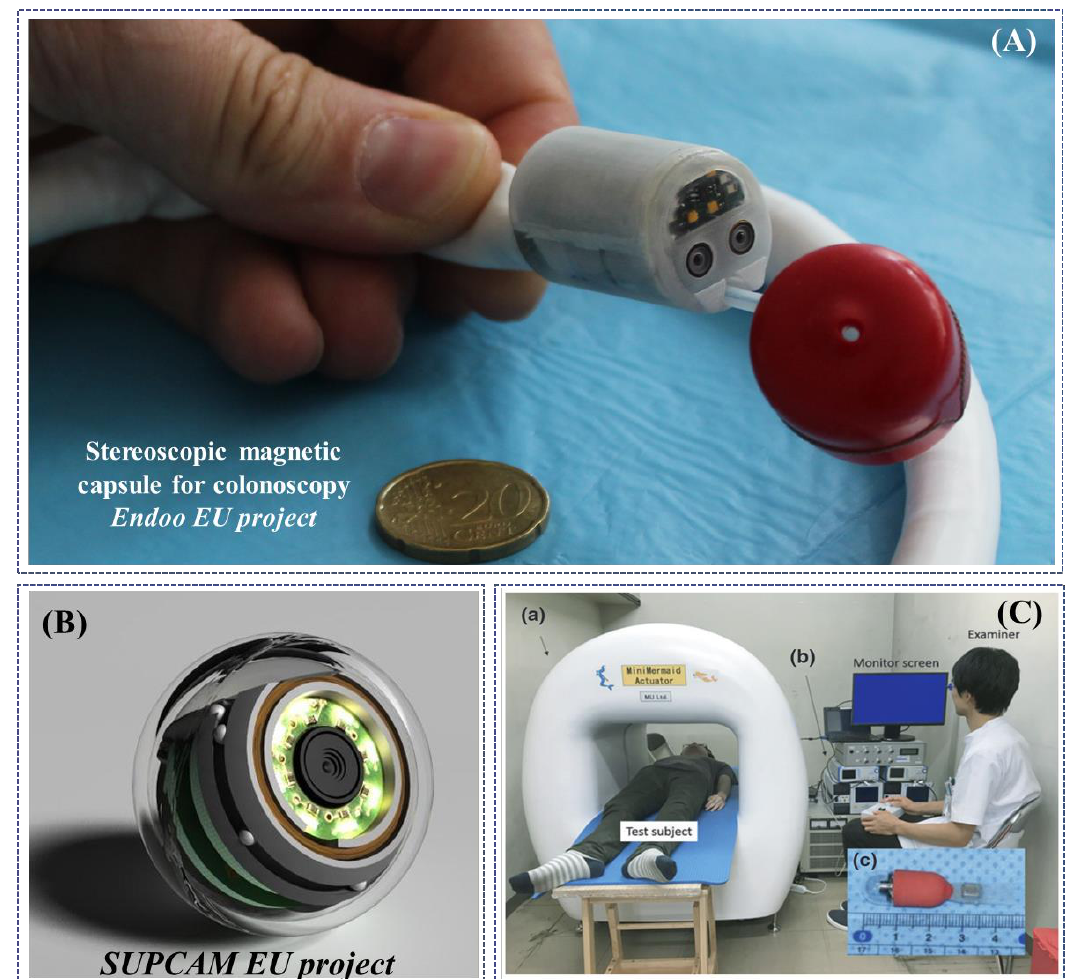
Figure 6. Examples of research-oriented innovative robotic colonoscopes and devices with magnetic or electromagnetic actuations: ( A ) Endoo EU project capsule (Courtesy of the Endoo consortium); ( B ) SUPCAM EU project spherical magnetic capsule for colonoscopy (Courtesy of Dr. Alessandro Tozzi); ( C ) modified PillCam TM SB2 with a silicone fin for magnetic locomotion through external electromagnetic fields, developed by Nouda et al. [128].